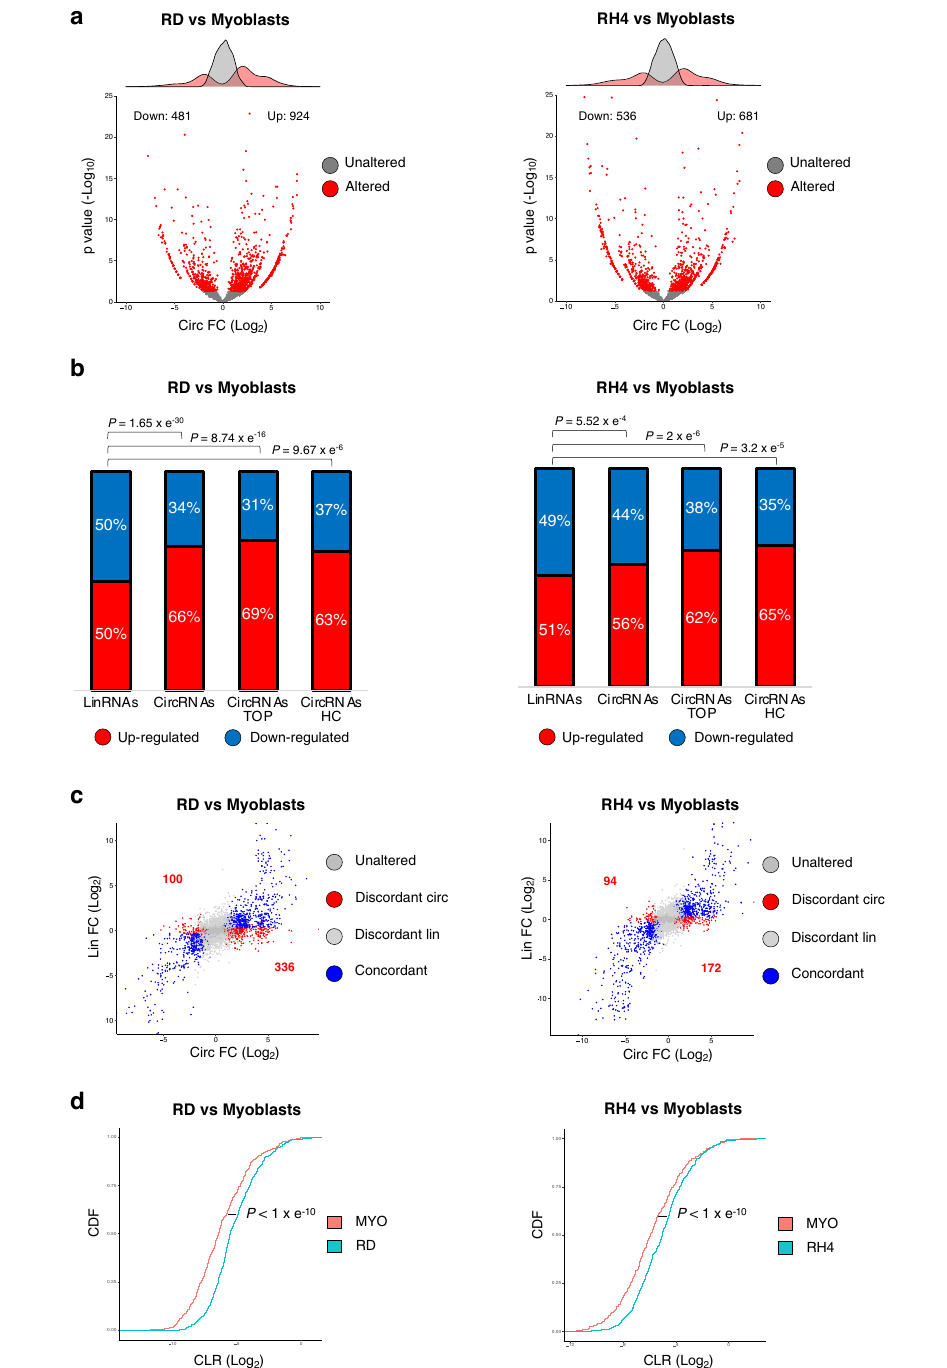
Fig.1|CircRNAlevelsincreaseinRMS.a Volcanoplotsshowing,foreachcircRNA identi fi ed in the RNA-Seq experiment, the log 2 fold change and the − log 10 p value eitherinthecomparisonbetweenRD(leftpanel)orRH4(rightpanel)celllinesand wild-type myoblasts. The distributions of the fold change values are shown above the volcano plots. Signi fi cantly altered circRNAs ( p value <0.05) or unaltered cir- cRNAs are indicated by red or gray dots, respectively. b Stacked bar charts with percentage of down- and upregulated linear ( “ LinRNAs ” ), circRNAs ( “ CircRNAs ” ), top 20% expressed circRNAs ( “ CircRNAs TOP ” ) or “ high-con fi dence ” circRNAs ( “ CircRNAs HC ” ) in the comparison between RD and wild-type myoblasts (left panel) or between RH4 and wild-type myoblasts (right panel). P values for the differencesbetweenproportionswerecalculatedusingFisherexacttwo-tailedtest. c Scatterplotsshowing,foreachcircRNAidenti fi edintheRNA-seqexperiment,the log 2 fold change along with that of its cognate linear RNA, in the comparison